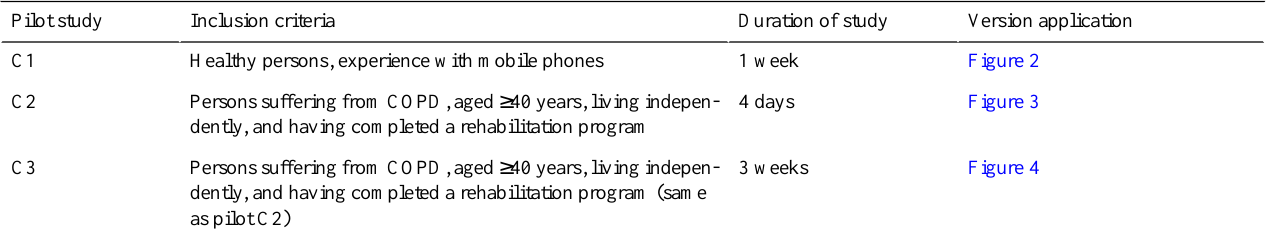
Table 1. Characteristics of the three pilot studies in study phase